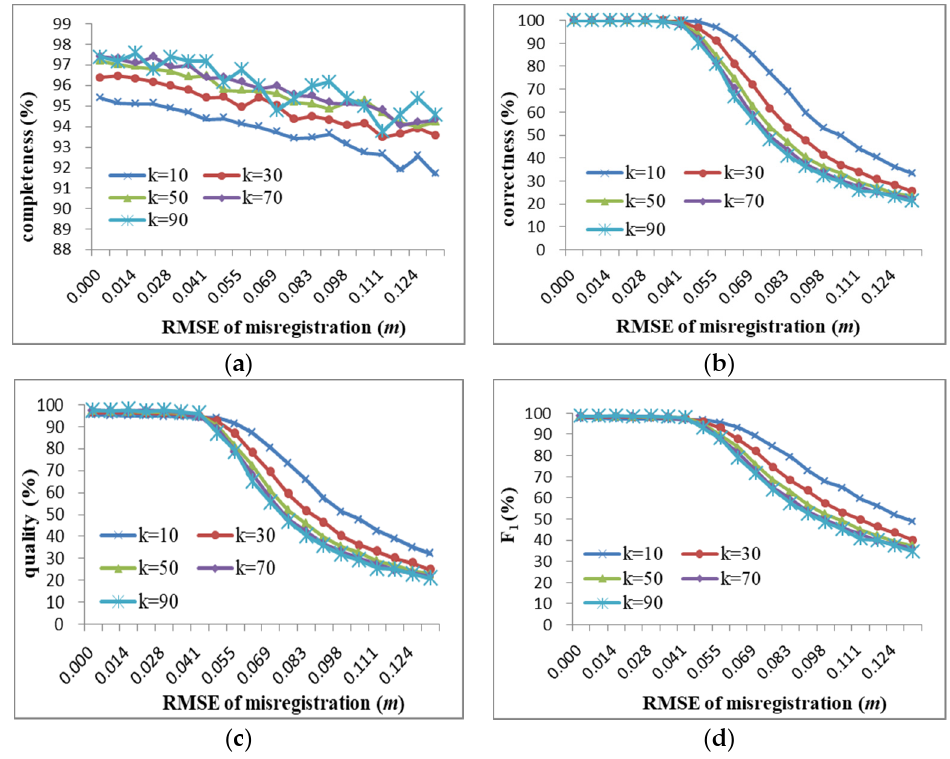
Figure 8. Results of experiments 3: ( a – d ) the results of the indicators completeness, correctness, quality and F 1 , respectively, with varying number of neighboring points.